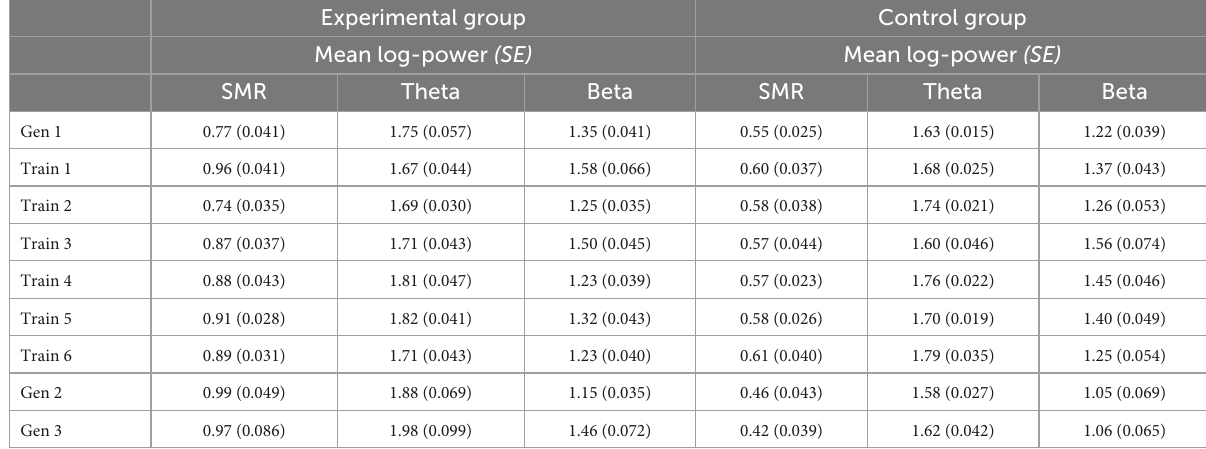
TABLE 2 Between session changes in mean log-transformed SMR, Theta, and Beta power, presented separately for the experimental and control group with Cosineau-Morey transformed standard errors.